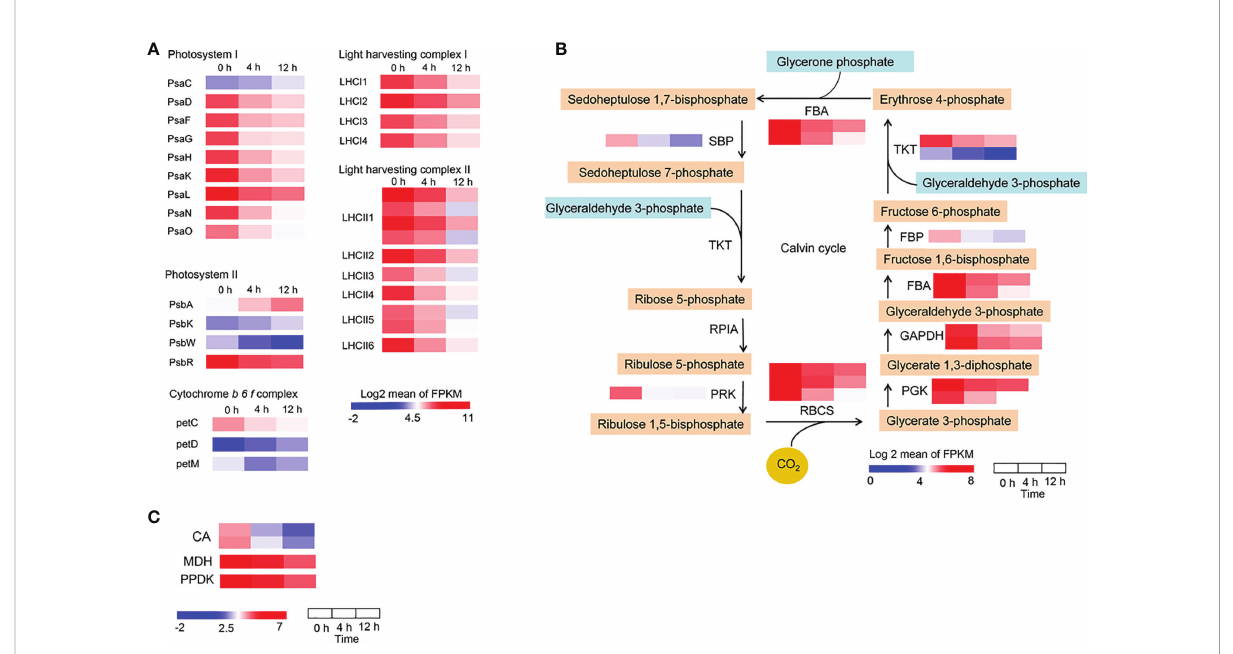
FIGURE 7 Changes in the expression of photosynthetic genes in response to salt treatment. (A) Expression pattern of genes encoding photosynthetic proteins, including the photosystem I complex, light harvesting complex I, photosystem II complex, light harvesting complex II, and cytochrome b 6 f complex. (B) Heatmaps of genes involved in the Calvin cycle. SBP, sedoheptulose-1,7-bisphosphatase; TKT, transketolase; RPIA, ribose 5- phosphate isomerase A; PRK, phosphoribulokinase; RBCS, ribulose-bisphosphate carboxylase small chain; PGK, phosphoglycerate kinase; GAPDH, glyceraldehyde 3-phosphate dehydrogenase; FBA, fructose-bisphosphate aldolase; FBP, fructose-1,6-bisphosphatase I (C) Heatmaps of genes involved in the CAM pathway. CA, carbonic anhydrase; MDH, malate dehydrogenase; PPDK, pyruvate, phosphate dikinase. Genes that changed signi fi cantly at least one time point after salt treatment are